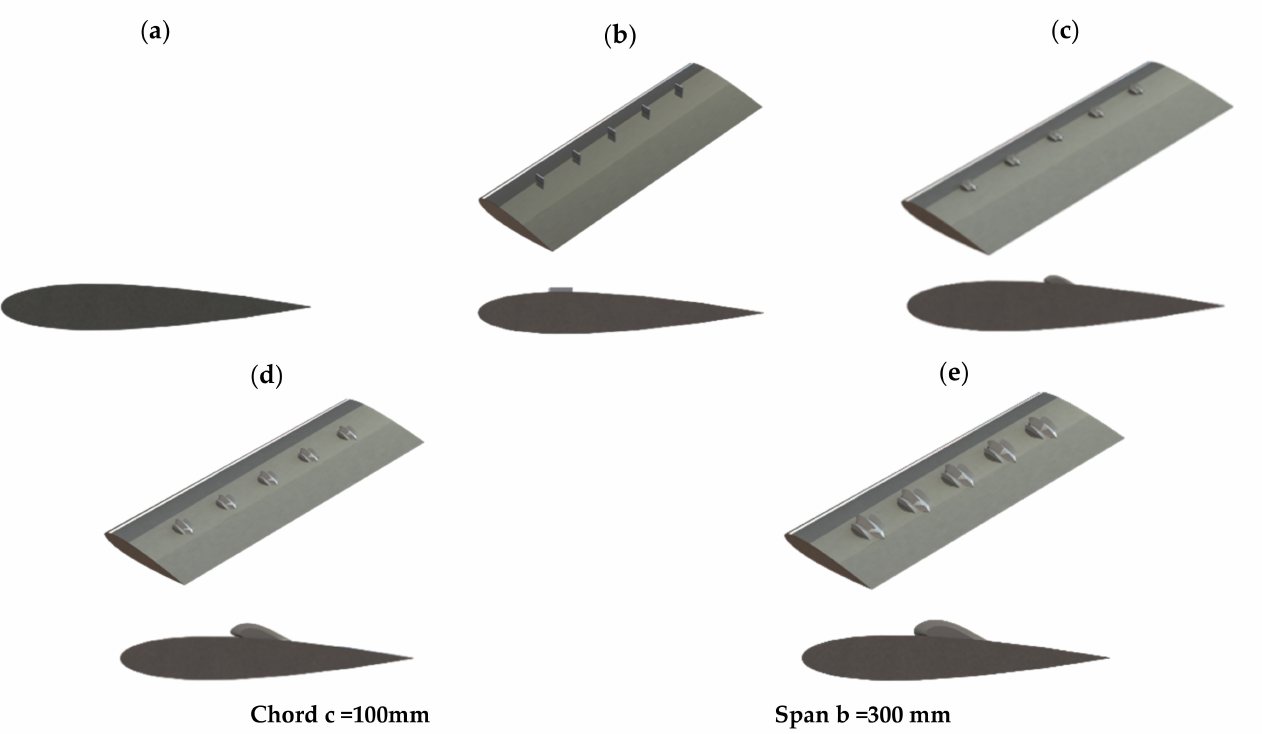
Figure 2. A schematic representation of test models: ( a ) baseline clean wing, ( b ) conventional rectangular vortex generator (VG), ( c ) 5S type shark scale vortex generators (SSVG), ( d ) 5M type SSVG, and ( e ) 5L type